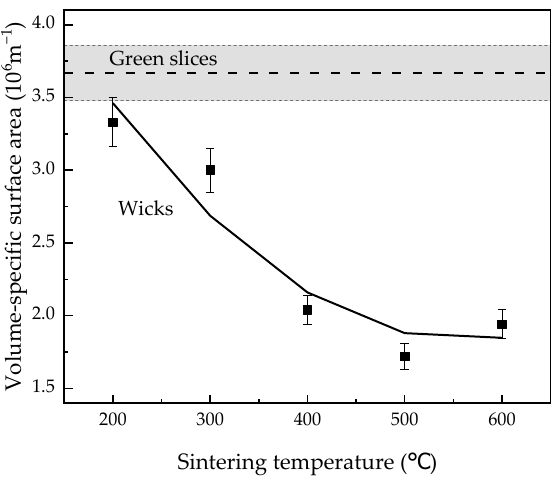
Figure 3. Volume-specific surface area of green slices and wicks sintered at different temperatures.